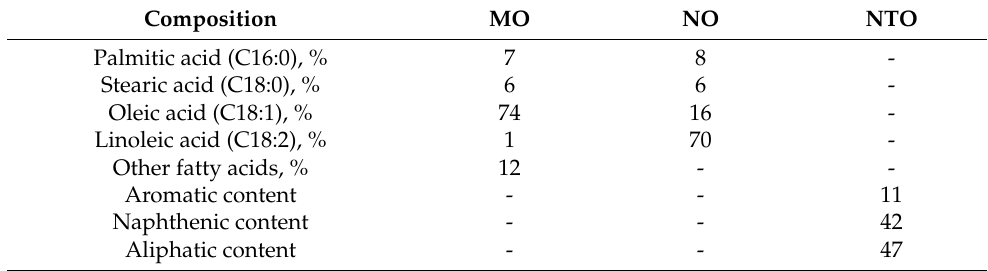
Table 1. The fatty acid compositions of MO [19–21], NO [22,23] and NTO [24].